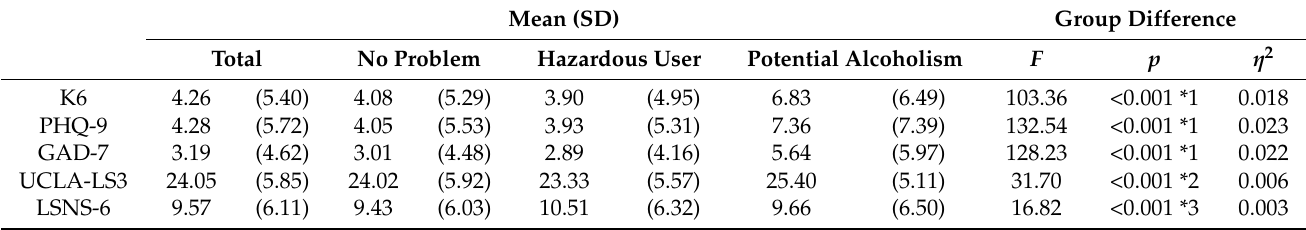
Table 4. Comparisons of psychological index scores between three AUDIT groups.